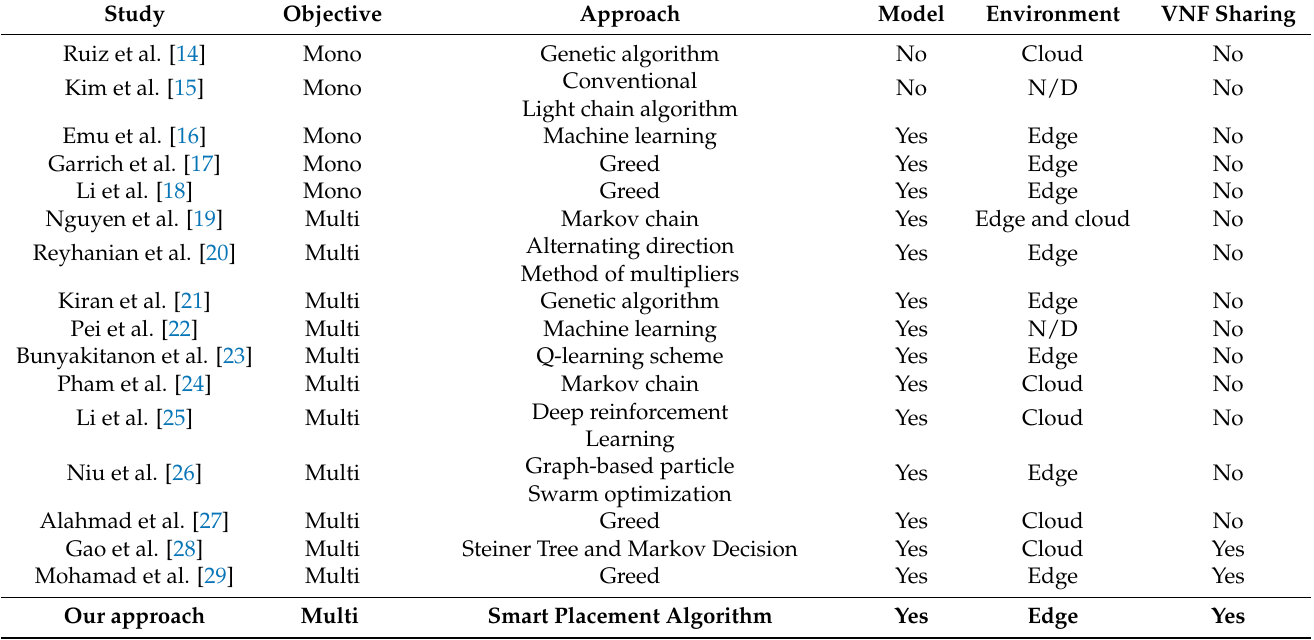
Table 1. Comparison of the related work with our